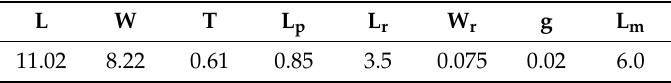
Table 3. Transducer dimensions (in mm).